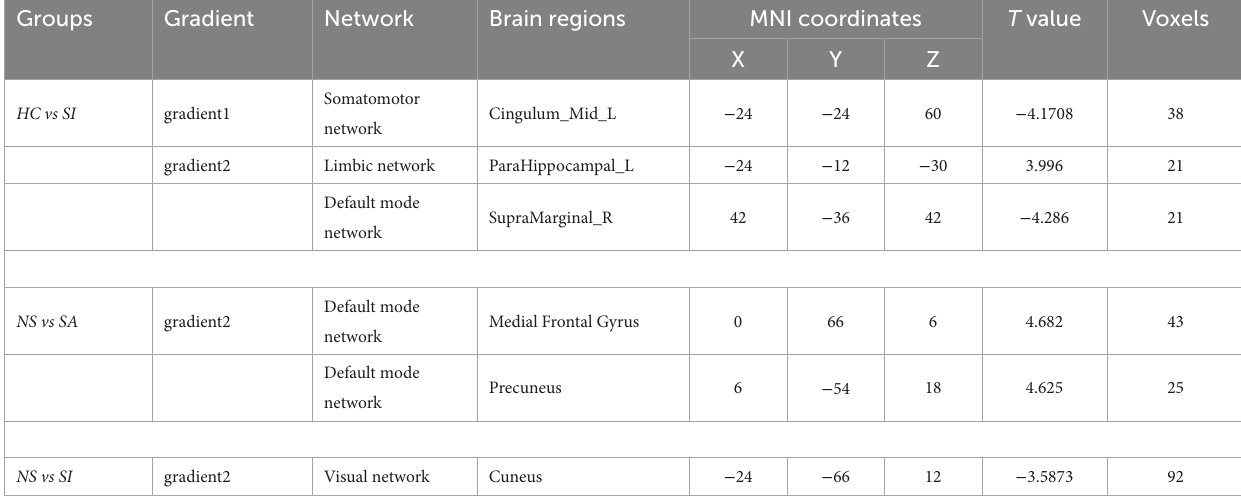
TABLE 2 Group differences in macroscale functional gradient.